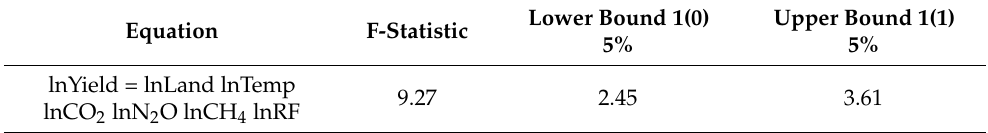
Table 2. Bounds test for co-integration.